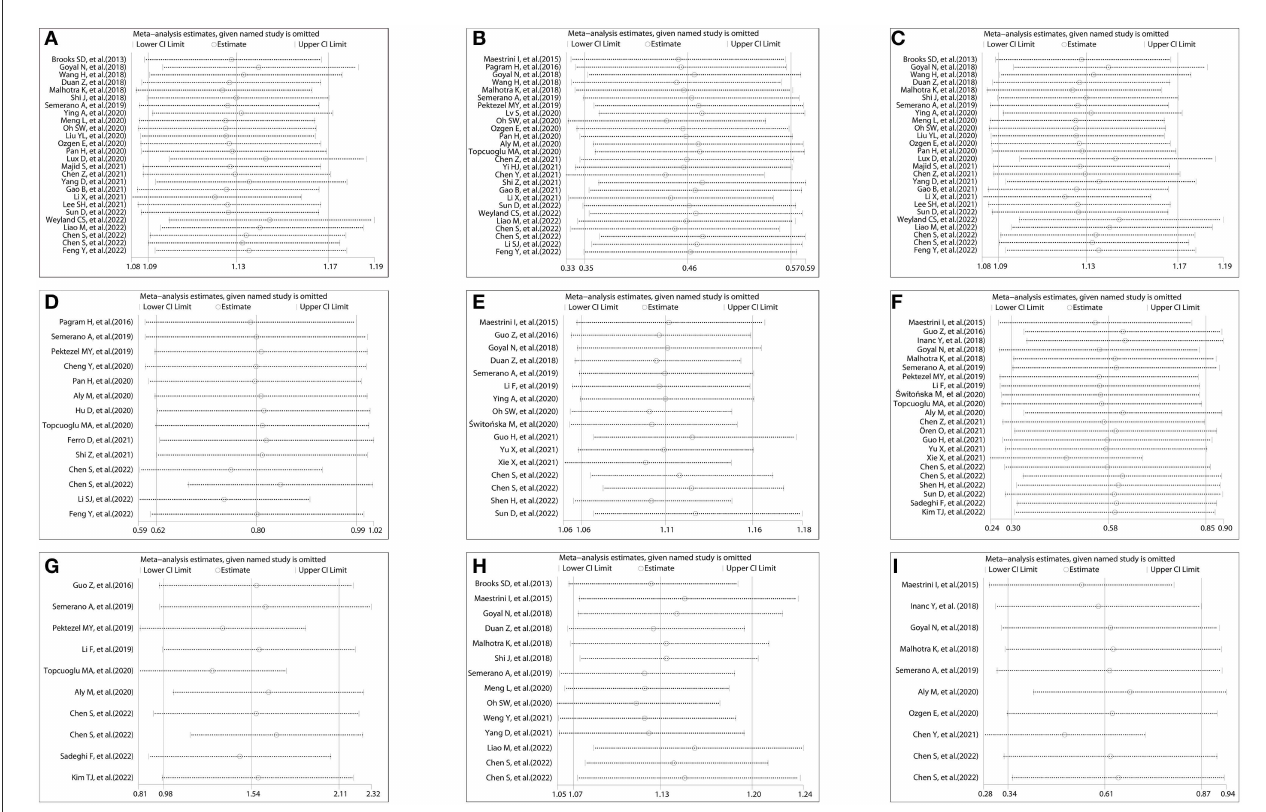
FIGURE6 Sensitivity analysis on the relationship between NLR and prognosis; (A) sensitivity analysis of admission NLR and 3-month PFO based on OR; (B) sensitivity analysis of admission NLR and 3-month PFO based on SMD; (C) sensitivity analysis of post-treatment NLR and 3-month PFO based on OR; (D) sensitivity analysis of post-treatment NLR and 3-month PFO based on SMD; (E) sensitivity analysis of admission NLR and sICH based on OR; (F) sensitivity analysis of admission NLR and sICH based on SMD; (G) sensitivity analysis of post-treatment NLR and sICH based on SMD; (H) sensitivity analysis of admission NLR and 3-month mortality based on OR; and (I) sensitivity analysis of admission NLR and 3-month mortality based on